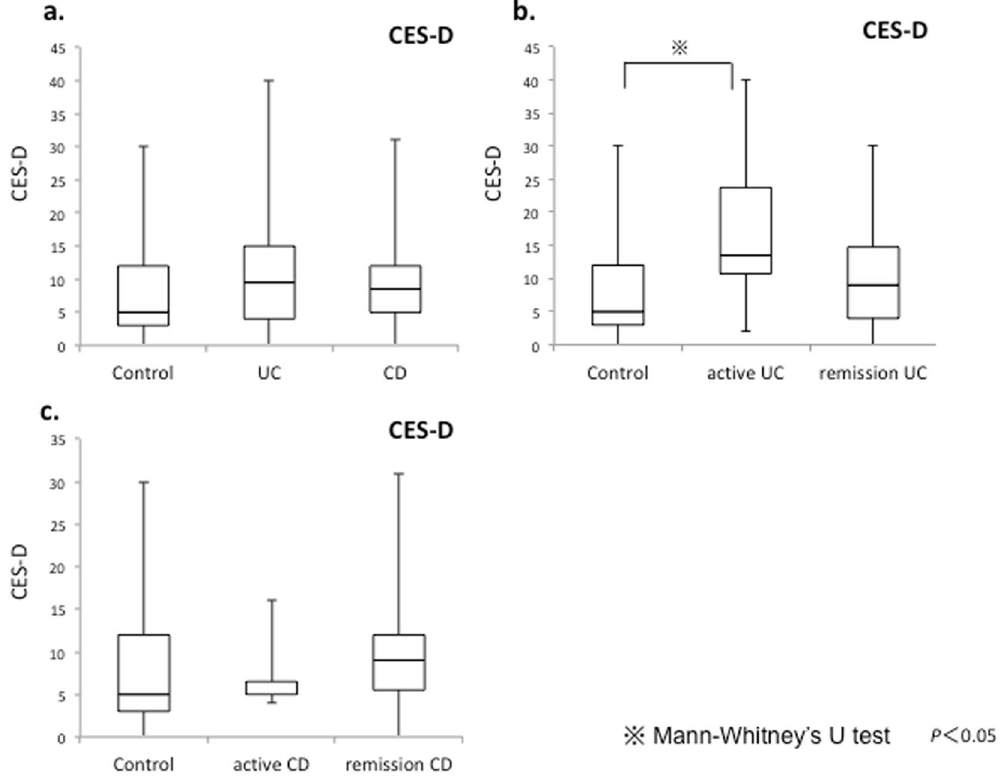
Figure 1. Comparisons of CES-D scores among the HC, UC, and CD groups; HC, active UC, and UC in remission groups; and HC, active CD, and CD in remission groups. ( a ) Scores in the UC and CD groups do not differ significantly from HC group scores. ( b ) Scores in the active UC group are significantly higher compared with the HC group. ( c ) Scores in the active CD and remission CD groups do not differ significantly from HC group scores.